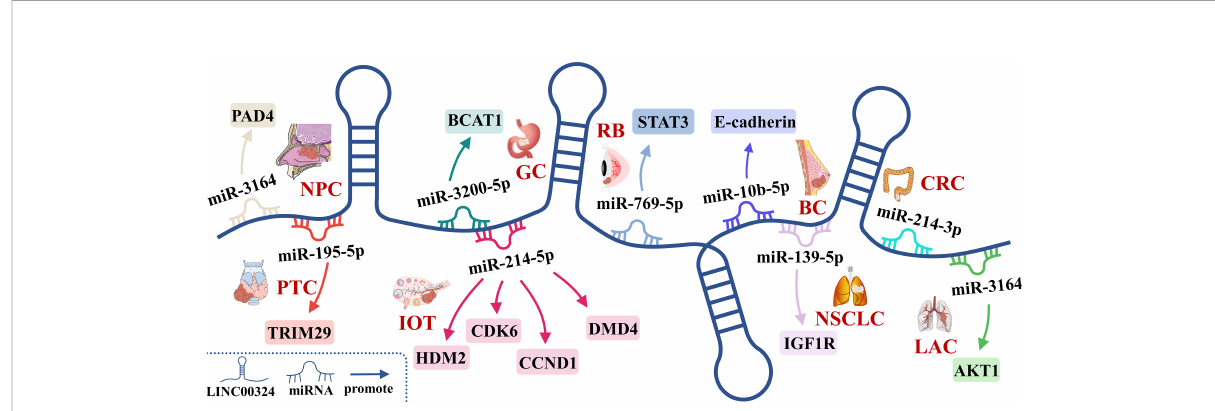
FIGURE 3 The competing endogenous RNA (ceRNA) mechanism and potential downstream regulatory mechanisms of LINC00324. BC, Breast cancer; CRC, Colorectal cancer; GC, Gastric cancer; IOT, Immature ovarian teratocarcinoma; LAC, Lung adenocarcinoma; NPC, Nasopharyngeal carcinoma; NSCLC, Non-small cell lung carcinoma; PTC, Papillary thyroid cancer; RB, Retinoblastoma.